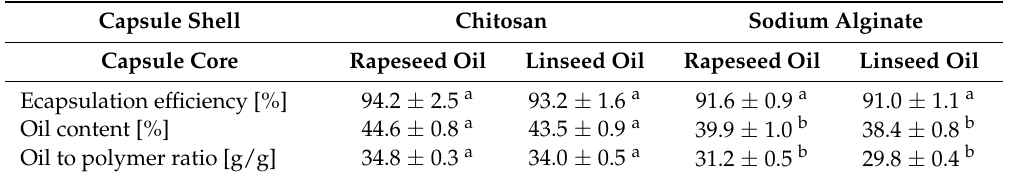
Table 1. Comparison of the encapsulation efficiency, the content of oil in capsules, and the oil-to-polymer mass ratio, depending on the shell and the core composition of the